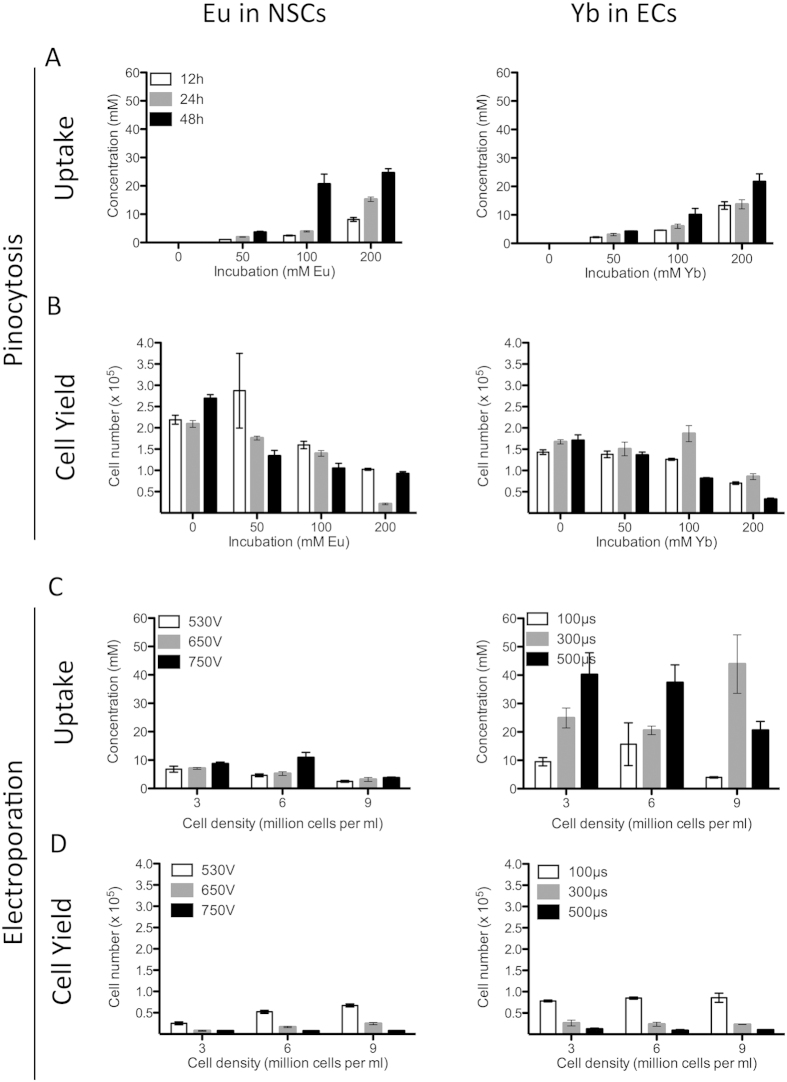
Cell labeling.(A) With pinocytosis, uptake was increased in both cell types by increasing concentration (F = 132, p < 0.0001 for NSCs and F = 101, p < 0.0001 for ECs) and incubation time (F = 72, p < 0.0001 for NSCs and F = 12, p < 0.001 for ECs), with a significant interaction between time and concentration (F = 20, p < 0.0001 for NSCs and F = 13, p < 0.05 for ECs). (B) Survival was decreased in both cell types by increasing concentration (F = 29, p < 0.0001 for NSCs and F = 64, p < 0.0001 for ECs) and incubation time (F = 6, p < 0.01 for NSCs and F = 22, p < 0.0001 for ECs), with a significant interaction between time and concentration (F = 4, p < 0.01 for NSCs and F = 8, p < 0.001 for ECs). (C) For electroporation in NSCs, uptake was increased by increasing voltage (F = 12, p < 0.001) and decreased by increasing cell density (F = 24, p < 0.0001). For ECs, uptake by electroporation was increased by increasing pulse length (F = 13, p < 0.0001), but was not affected by cell density (F = 0.1, p = 0.90). (D) In NSCs, survival after electroporation was decreased by increasing voltage (F = 259, p < 0.0001) but increased by increasing cell density (F = 55, p < 0.0001). For ECs, survival after electroporation was decreased by increasing pulse length (F = 197, p < 0.0001), but was not affected by cell density (F = 0.02, p = 0.98).